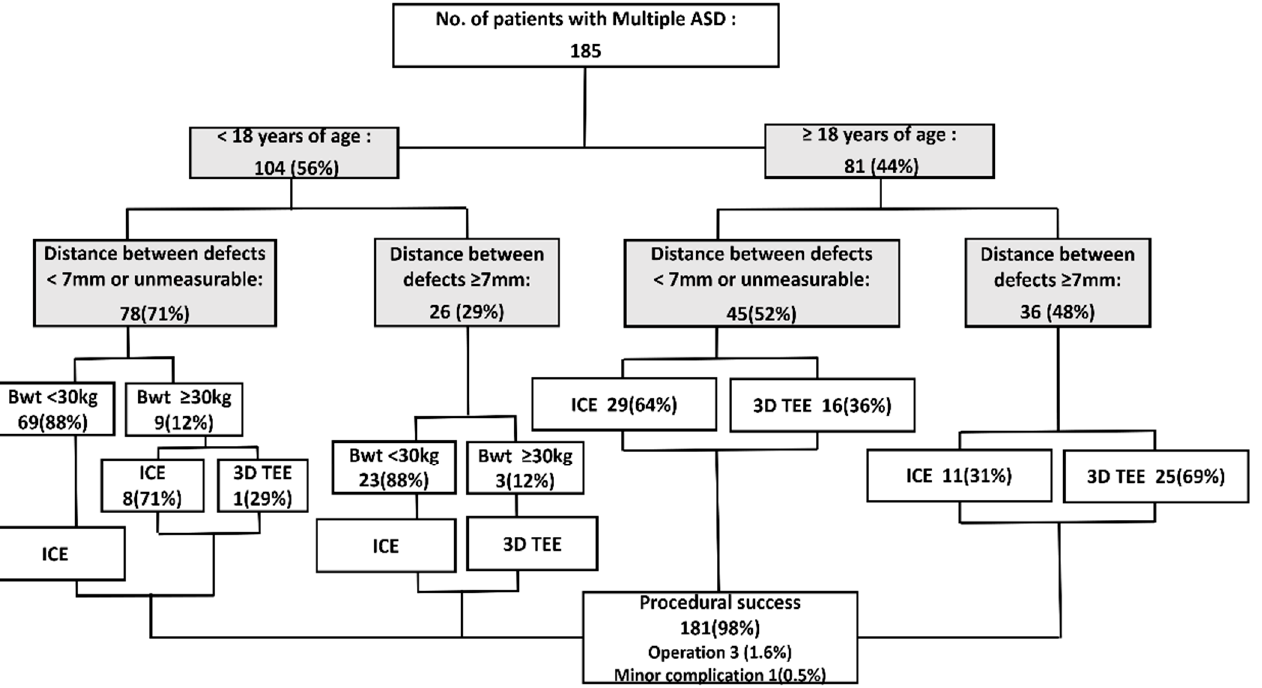
Figure 4. Summary of the echocardiographic tool selection strategy for patients with multiple atrial septal defects requiring transcatheter closure.ASD, atrial septal defect; Bwt, body weight; ICE, intracardiac echocardiography; RT 3D TTE, Real-time three-dimensional transesophageal echocardiography; TEE, transesophageal echocardiography